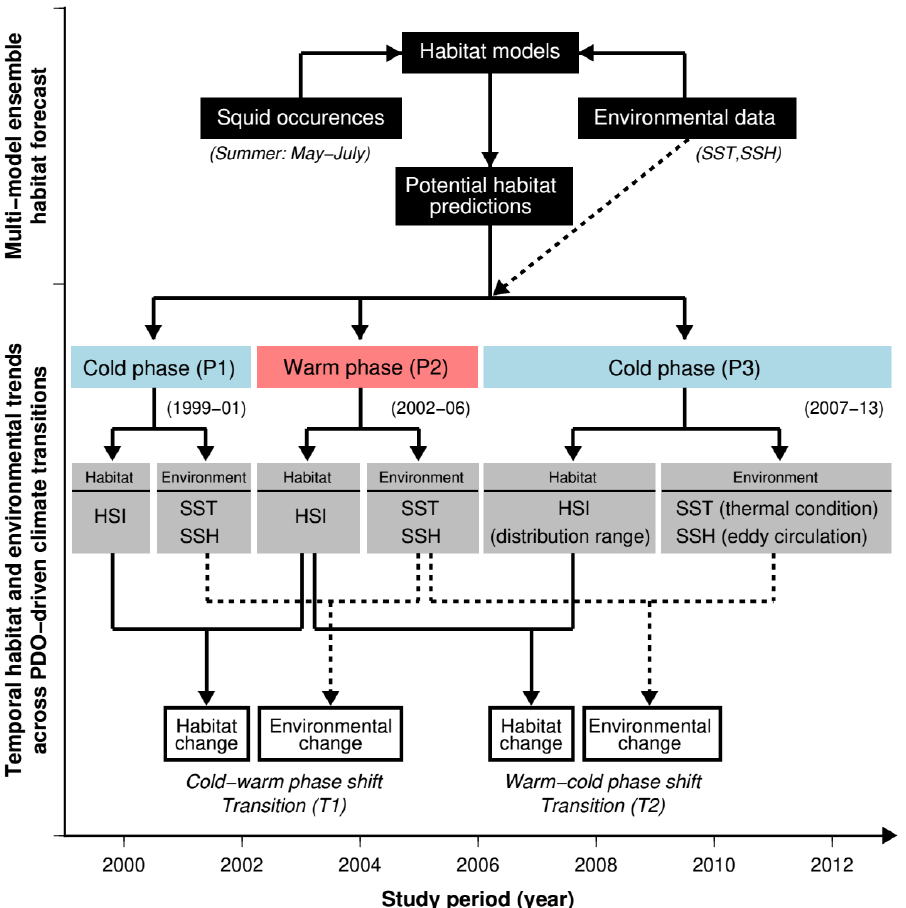
Figure 3. Analytical framework used for the study. Multi-model ensemble were constructed to elucidate the summer potential squid habitat over a 15-year period, punctuated by distinct phase transitions of Pacific decadal oscillation (PDO). The magnitude and rate of spatial changes in the potential squid habitat and oceanographic conditions were quantified based on the temporal trends in the habitat suitability index (HSI), thermal environment (sea surface temperature; SST) and mesoscale circulation (sea surface height; SSH) across the climatic transitions from cold to warm (Transition 1, T1: 1999–2006) and warm to cold PDO phase shift (Transition 2, T2: 2002–2013).